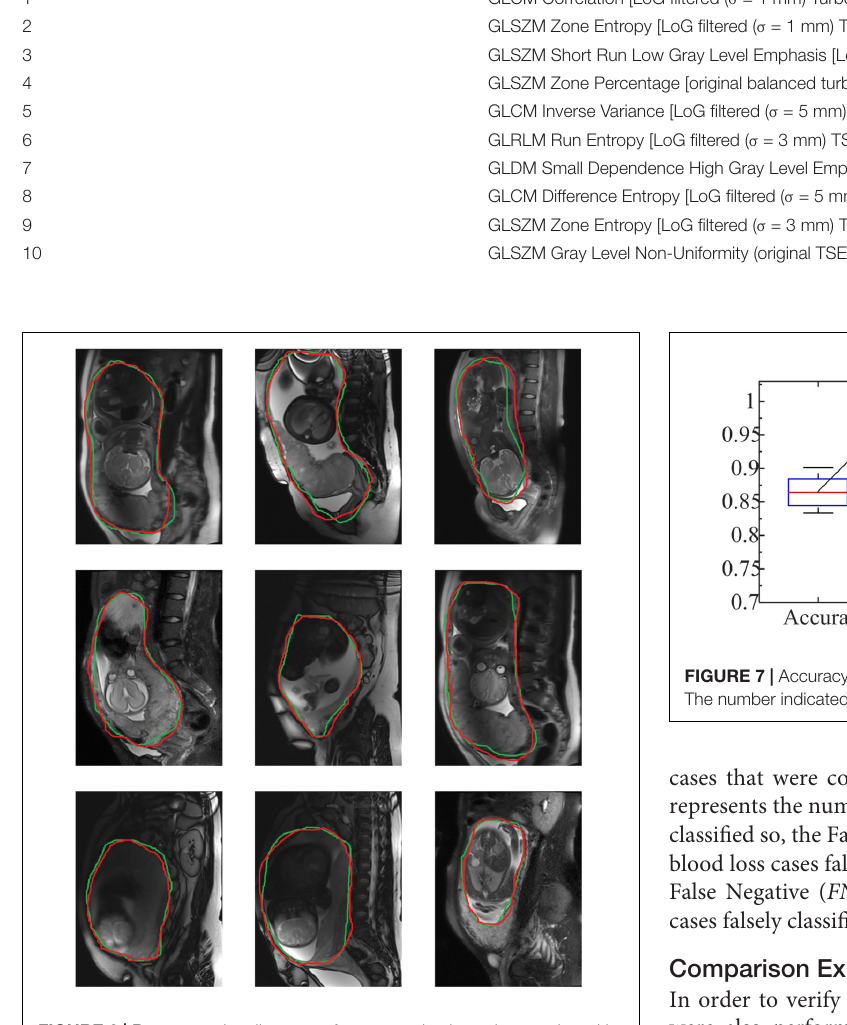
FIGURE 6 | Representative diagrams of segmentation boundary results, with green curves representing automatic segmentation, and red curves manual segmentation.